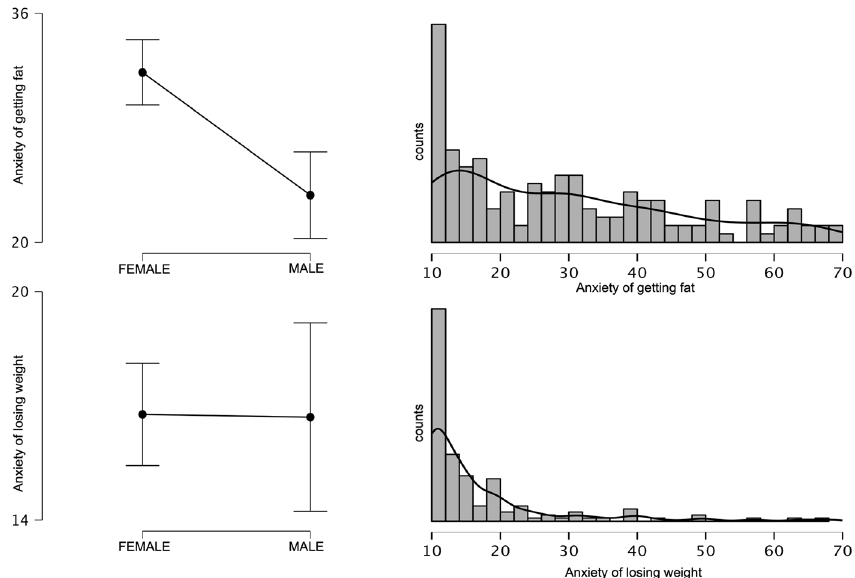
Figure 1. Gender differences and frequencies of the variables anxiety about getting fat and anxiety about losing weight.